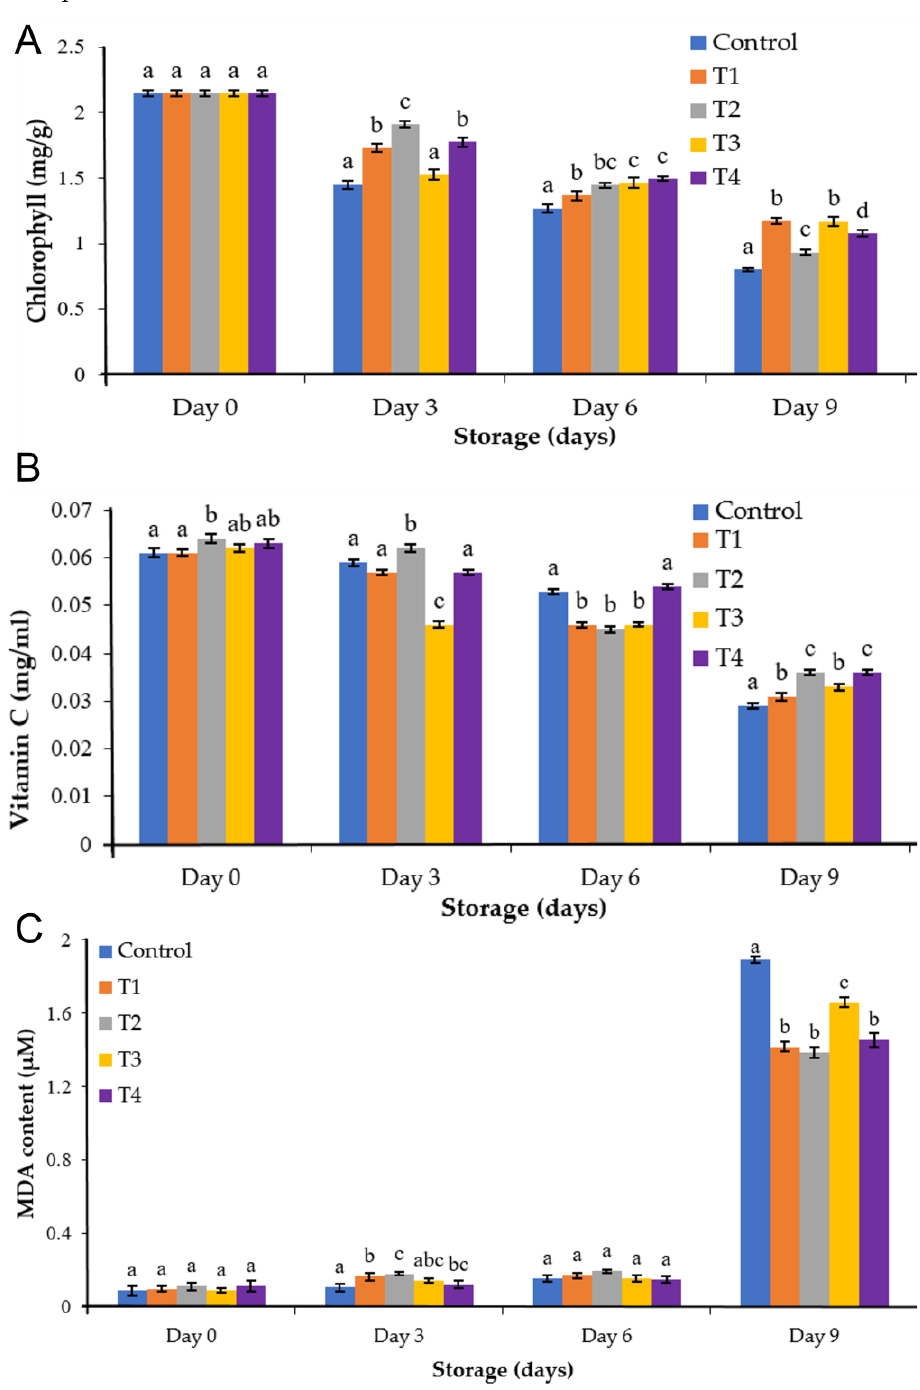
Figure 5. Changes in ( A ) chlorophyll content, ( B ) vitamin C, and ( C ) malondialdehyde of guava fruits at different maturity stages. Different lowercase letters (a–c) within the same group represent significant differences based on Tukey’s honest significance test ( p < 0.05). For sample codes, refer to Table 2.